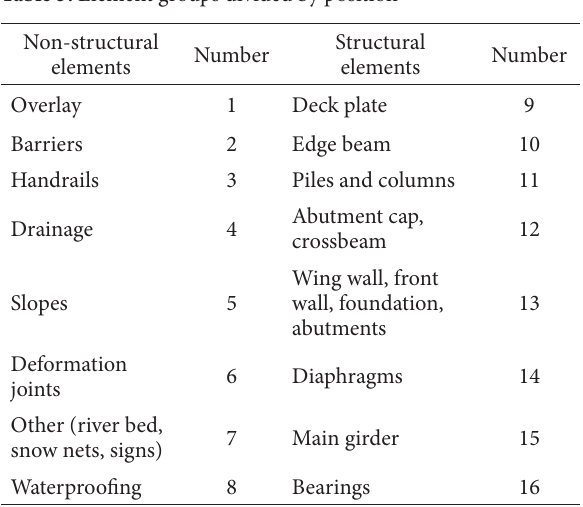
Table 3. Element groups divided by